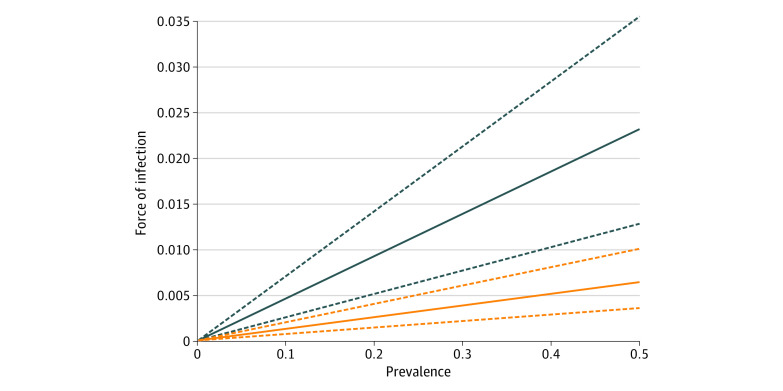
Association Between Prevalence and Force of InfectionIllustration of the association between ward prevalence and the estimated force of infection in a single general acute medicine ward contrasting the differential in the transmissibility of patients not with contact precautions (blue) with those with contact precautions (orange). The dashed lines represent the 95% CIs.